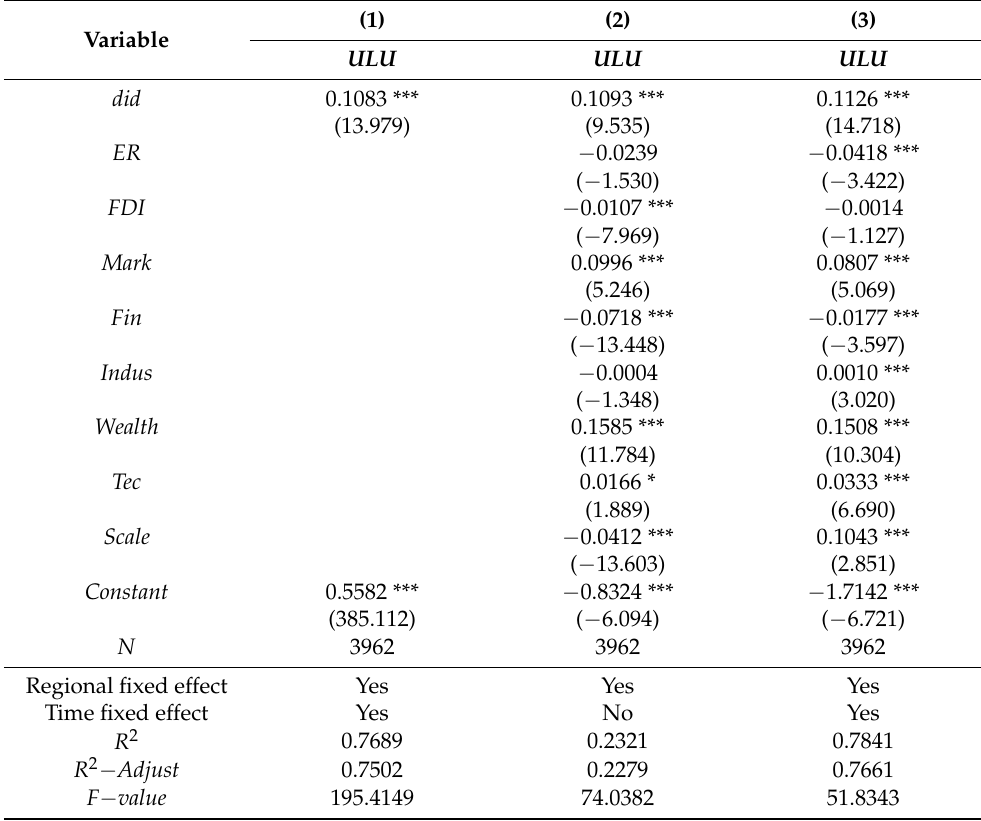
Table 4. Benchmark regression